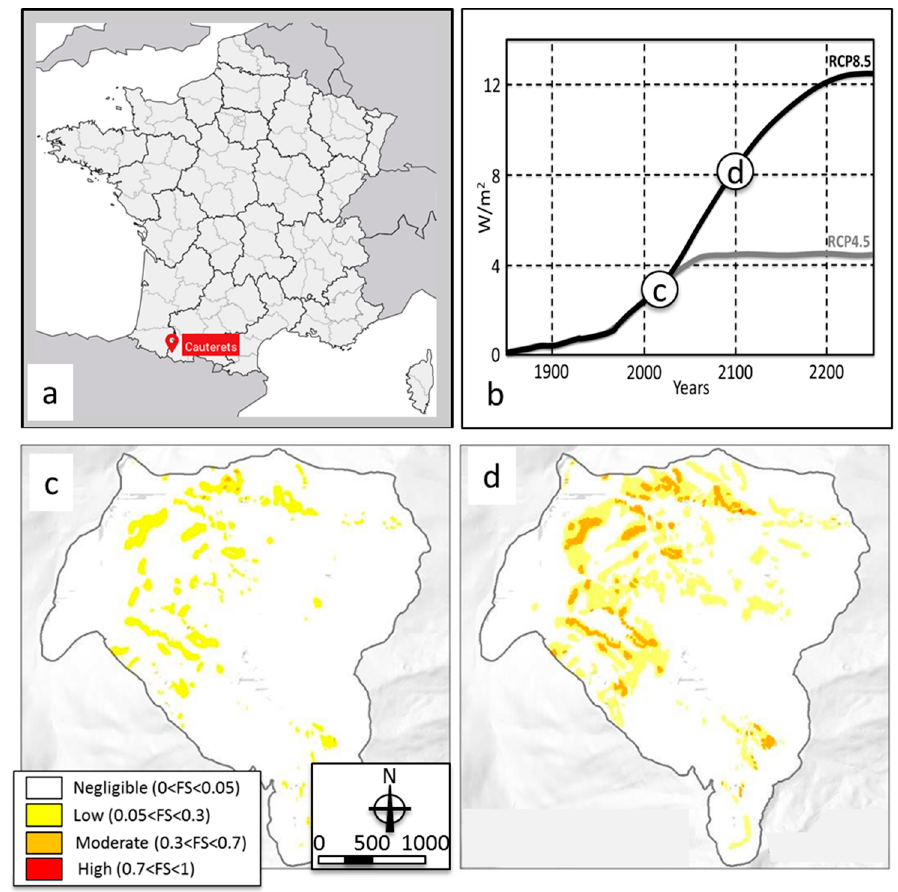
Figure 3. ( a ) Location of the Cauterets site; ( b ) radiative forcing over years for RCP4.5 (grey) and RCP8.5 (black) scenarios; and ( c ) Landslides hazard maps of the Cauterets site corresponding to a socio-economic scenario “sheeps and woods” at present days ( d ) and for a climatic evolution according to the RCP8.5 scenario at horizon 2100.